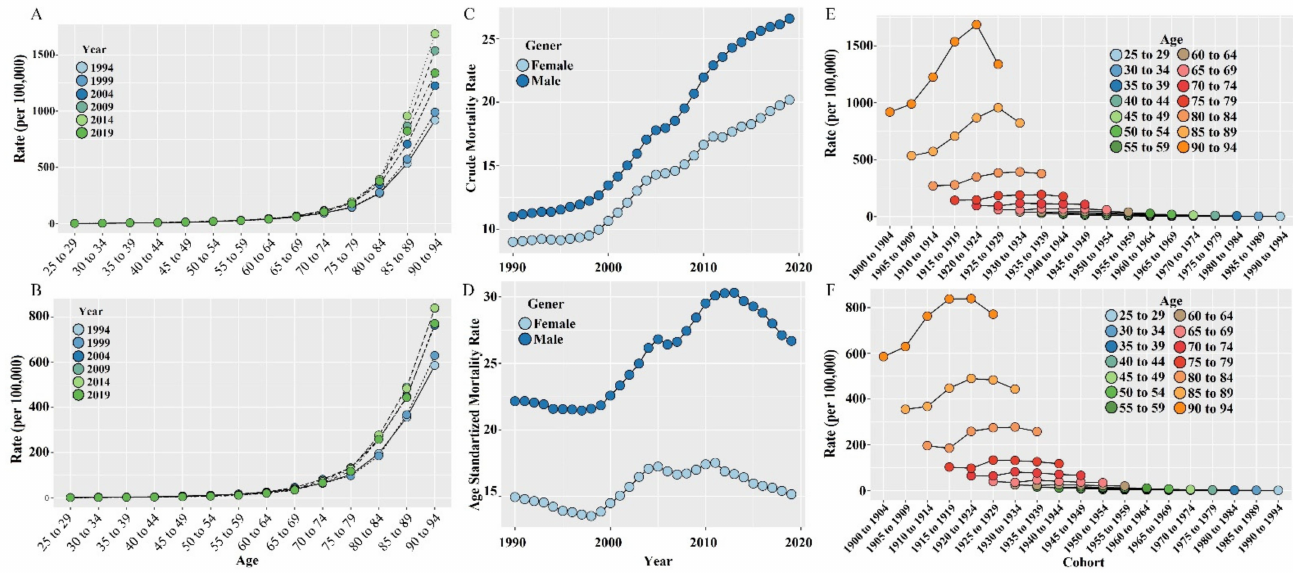
Figure 1. The long-term trends of low whole-grain intake attributed to CVD mortality (per 100,000) in China during 1990–2019. ( A ) Age-specific CVD mortality rates for males; ( B ) age-specific CVD mortality rates for females; ( C ) gender-specific CMR along with time periods; ( D ) gender-specific ASMR along with time periods; ( E ) age-specific CVD mortality rates along with birth cohorts for males; ( F ) age-specific CVD mortality rates along with birth cohorts for